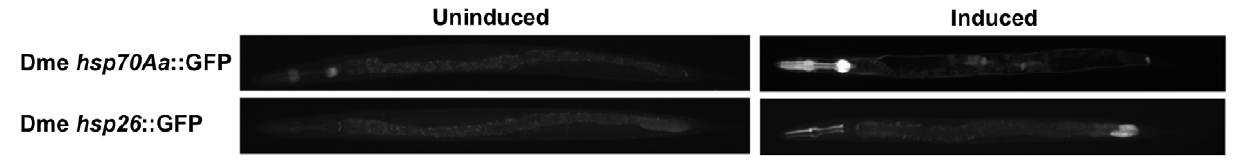
Figure 2. Expression patterns in C.elegans of Drosophila promoters of heat-shock genes fused to GFP. Worms were heat shocked at 33 u C for 1 hour and allowed to recover at 20 u C for 6–7 hours. Images are composites adjusted for exposure and taken in different planes.